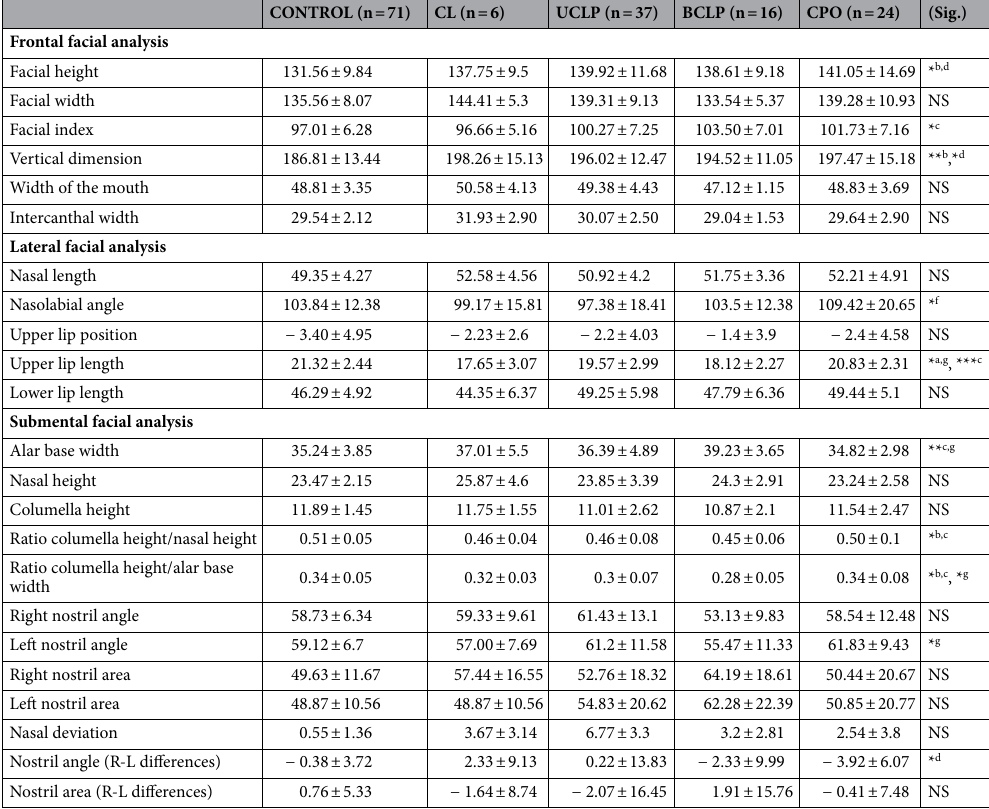
Table 3. Comparison of soft-tissue measurements between groups. Sig. Statistical significance, NS not significant. * p ≤ 0.05; ** p ≤ 0.01; *** p ≤ 0.001. a Controls versus CL. b Controls versus UCLP. c Controls versus BCLP. d Controls versus CPO. e CL versusUCLP. f UCLP versus CPO. g BCLP versus